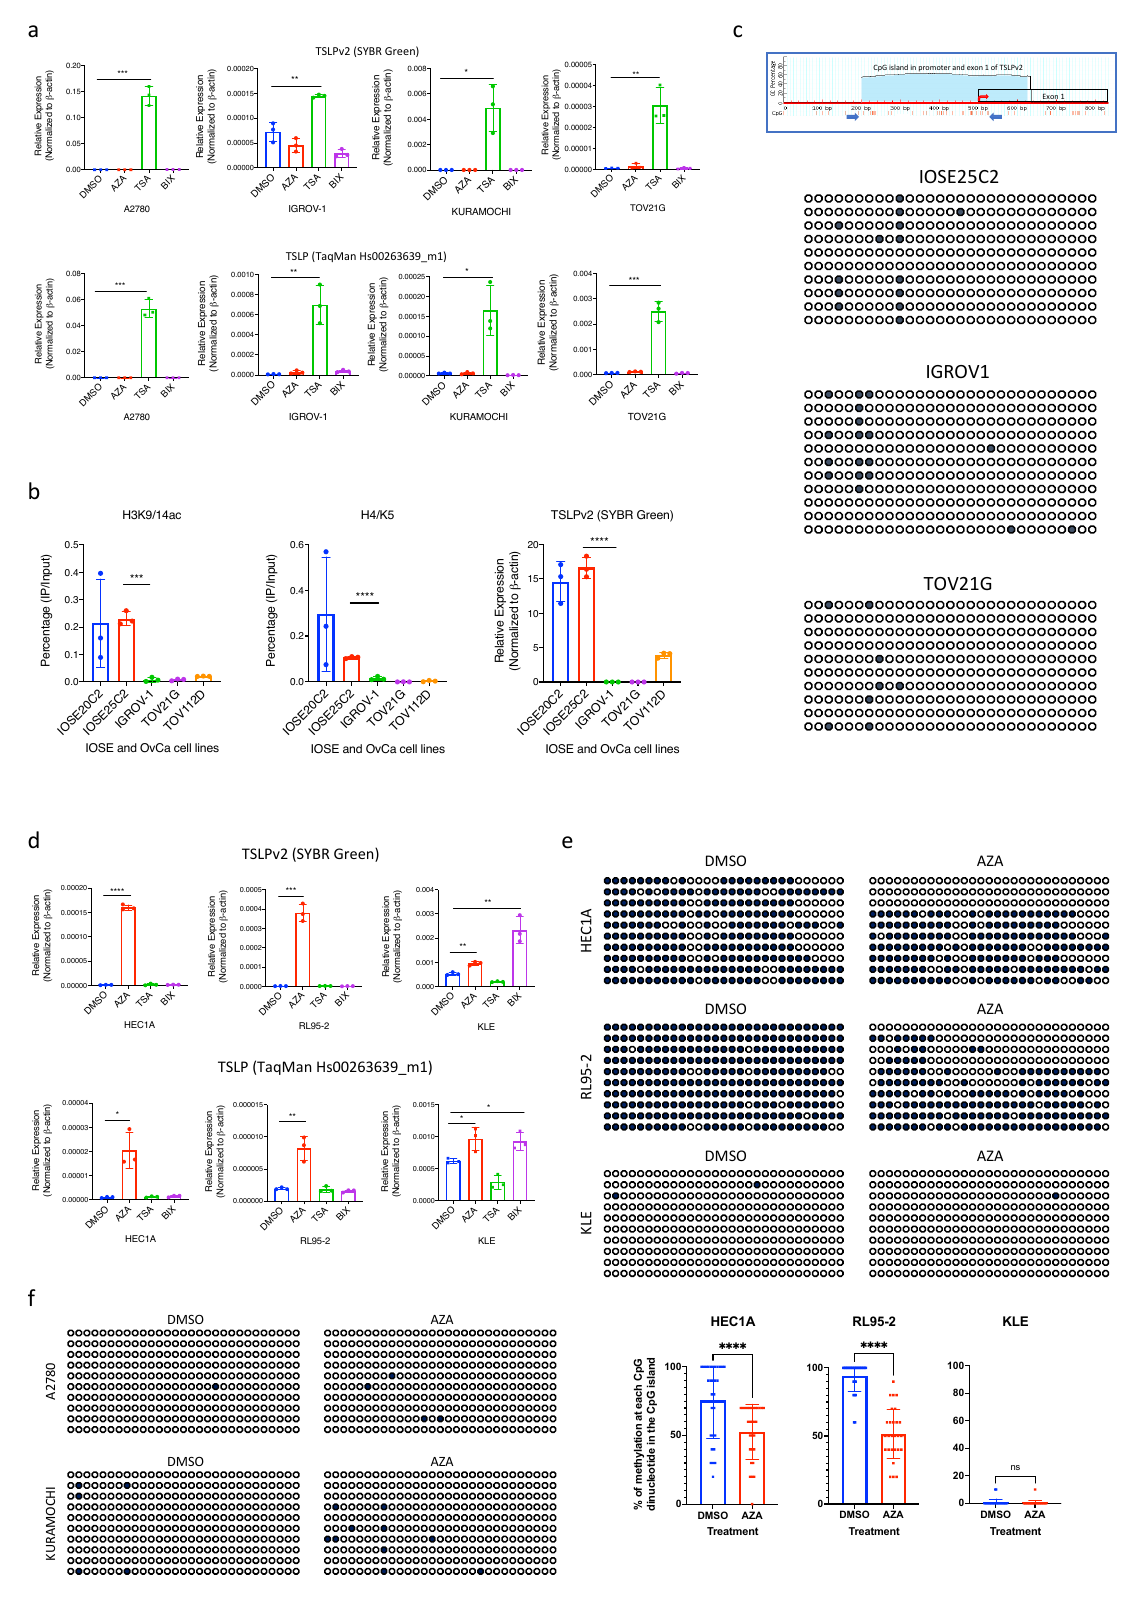
Figure 3. Epigenetic regulation of sfTSLP transcription in human ovarian and endometrial cancer cells. ( a ) mRNA expression of sfTSLP in TSLP-negative human ovarian cancer cell lines (A2780, IGROV-1, KURAMOCHI and TOV21G) after